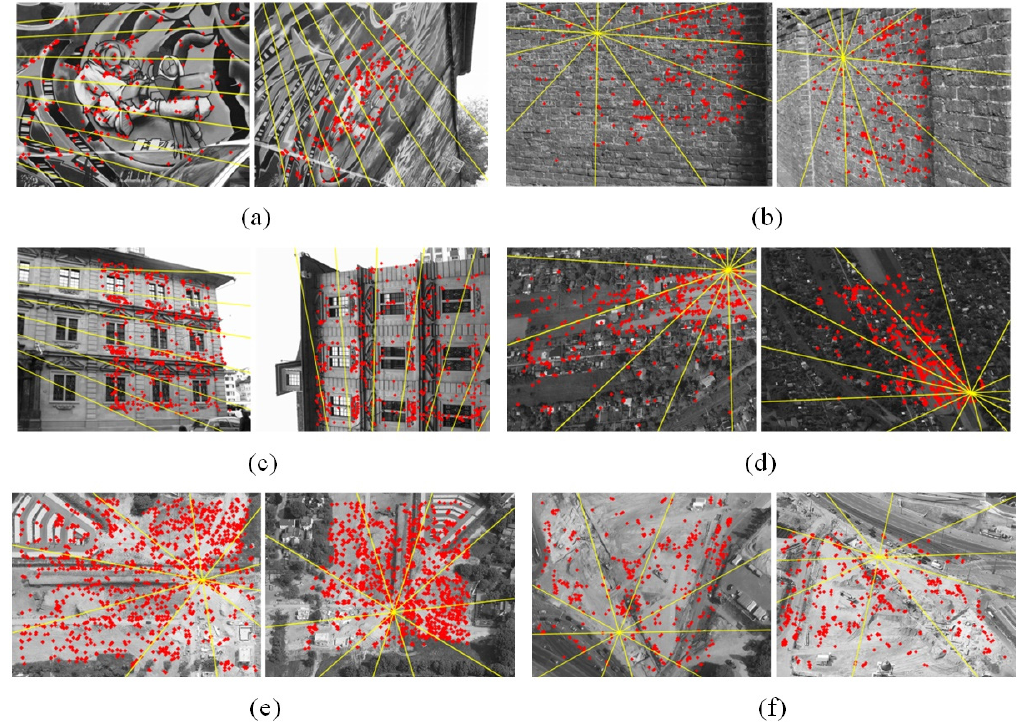
Figure 9. ( a )–( f ) Red points show the matching results of the proposed method with groups of stereo images. The yellow lines represent the epipolar lines estimated from matching points.